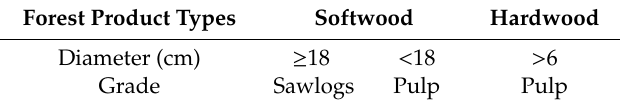
Table 3. Definition of forest product types and associated wood grades [42].